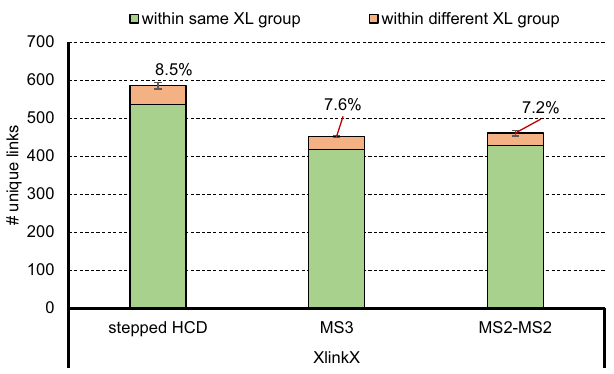
Fig. 9 Comparison of experimentally validated FDR of MSn methods. DSSO cross-linked main library were measured on an Eclipse Tribrid Mass Spectrometer using a stepped HCD MS2, MS3 and CID MS2- ETD MS2 acquisition strategy. Data was analyzed using XlinkX at 1% FDR. Red bars indicate false crosslinks whereas green bars represent true unique crosslinks. Error bars indicate standard deviations of average values, experimentally validated FDR is shown as callout, n = 3. Source data are provided as a Source Data fi